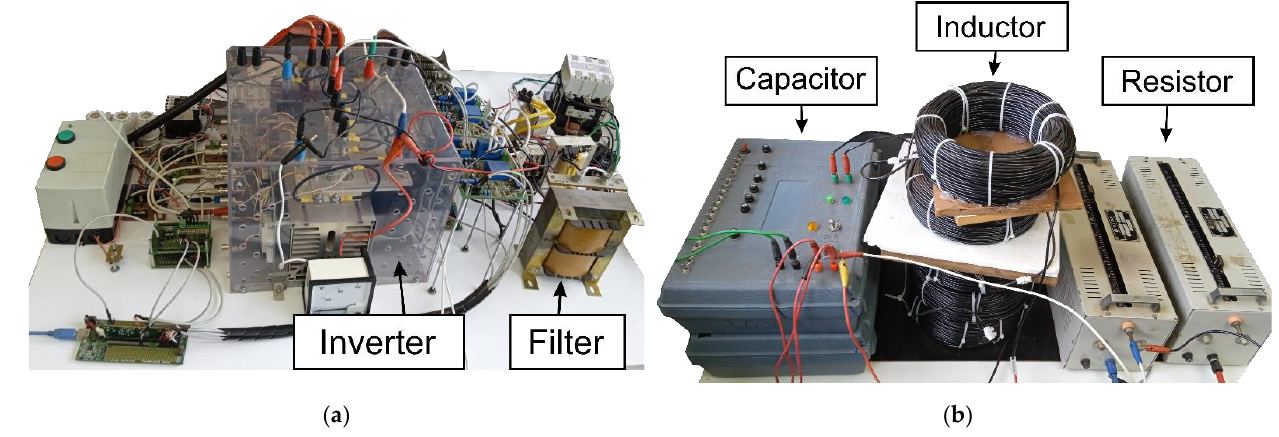
Figure 12. Experimental implementation: ( a ) Inverter prototype; ( b ) RLC experimental load.